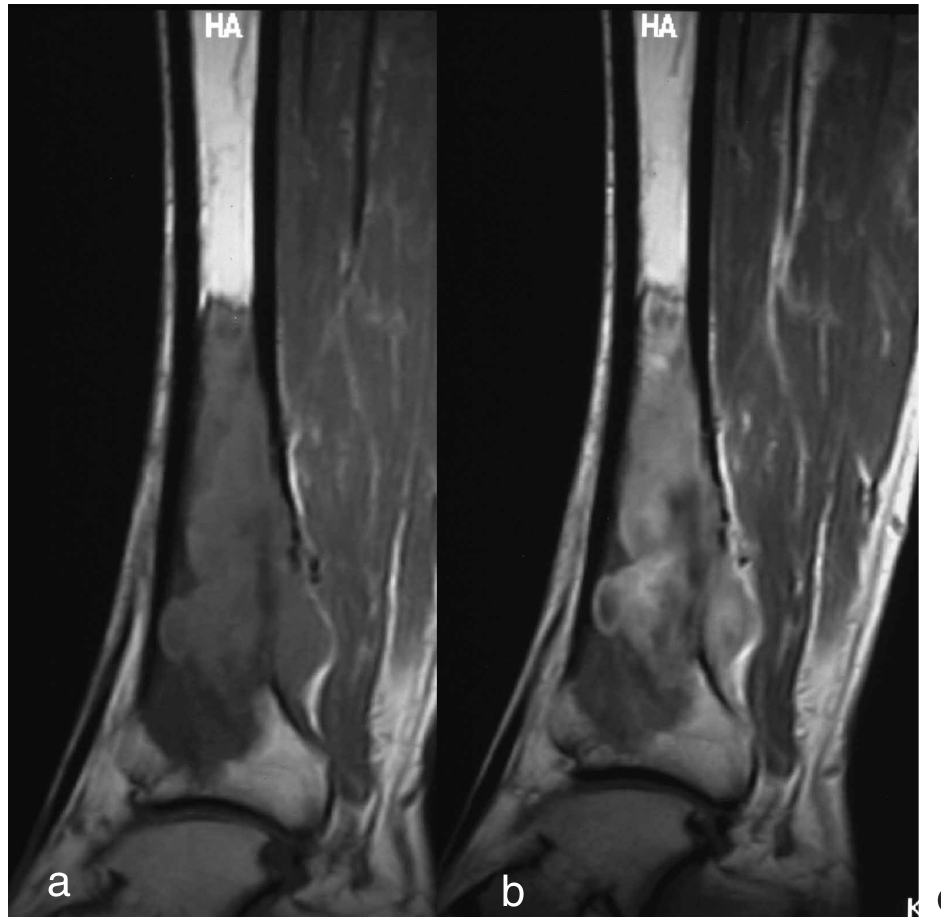
Fig. 2. Case 1 . (a) T1-weighted magnetic resonance (MR) imaging showed a low-signal intensity tumor with extra-skeletal projection. (b) Gadolinium-diethylenetriaminepentaacetic acid (DTPA)-enhanced T1-weighted images showed an inhomogeneously enhanced